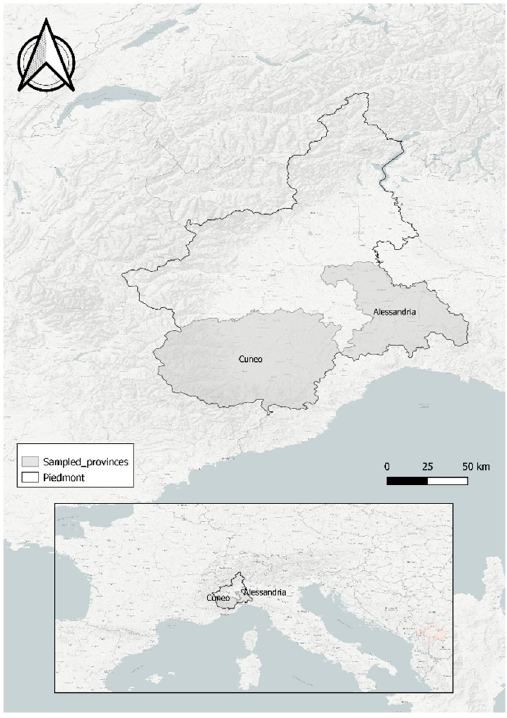
Figure 1. Piedmont region and localization of the sampled provinces of Alessandria and Cuneo in northwestern Italy.